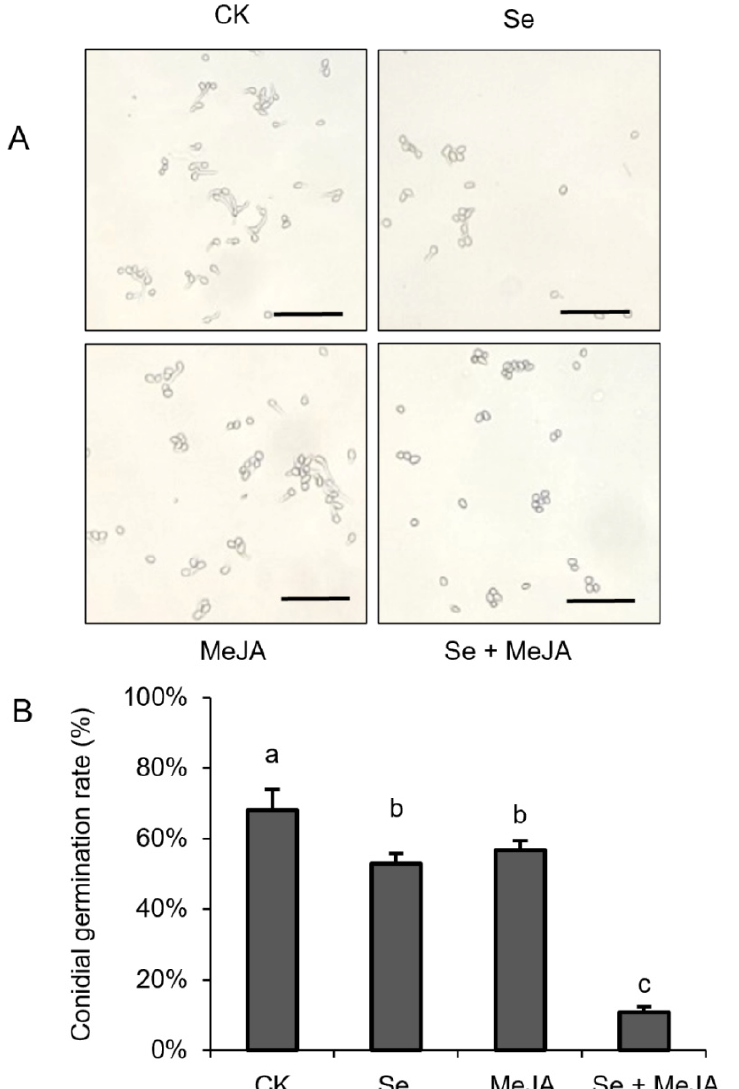
Figure 2. Effect of Se, MeJA and Se + MeJA on conidial germination. ( A ) Micrograph of conidial germination; ( B ) Conidial germination rate (n = 4). CK: Control group; Se: 5.0 mg/L Se; MeJA: 0.4 mM MeJA; Se + MeJA: 5.0 mg/L Se with 0.4 mM MeJA. Values with the same letter are not significantly different at p < 0.05 according to Duncan’s multiple range test. Bars = 40 μ m.